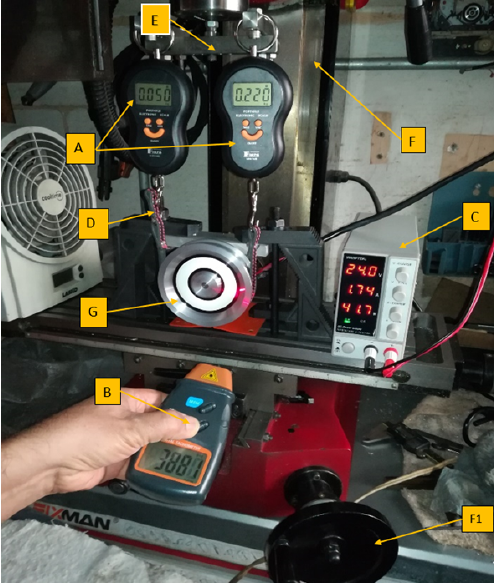
Figure 15. Motor characterization Components and set-up, ( A ) Dynamometers, ( B ) Digital laser tachometer, ( C ) Power supply, ( D ) Leather belt ½ (cid:48)(cid:48) wide and 1/8 (cid:48)(cid:48) thick, ( E ) Stainless steel cross support with longitudinal holes, ( F ) Milling machine with manual operation, ( F1 ) Flywheel for vertical axis movement, ( G ) CD motor with aluminum